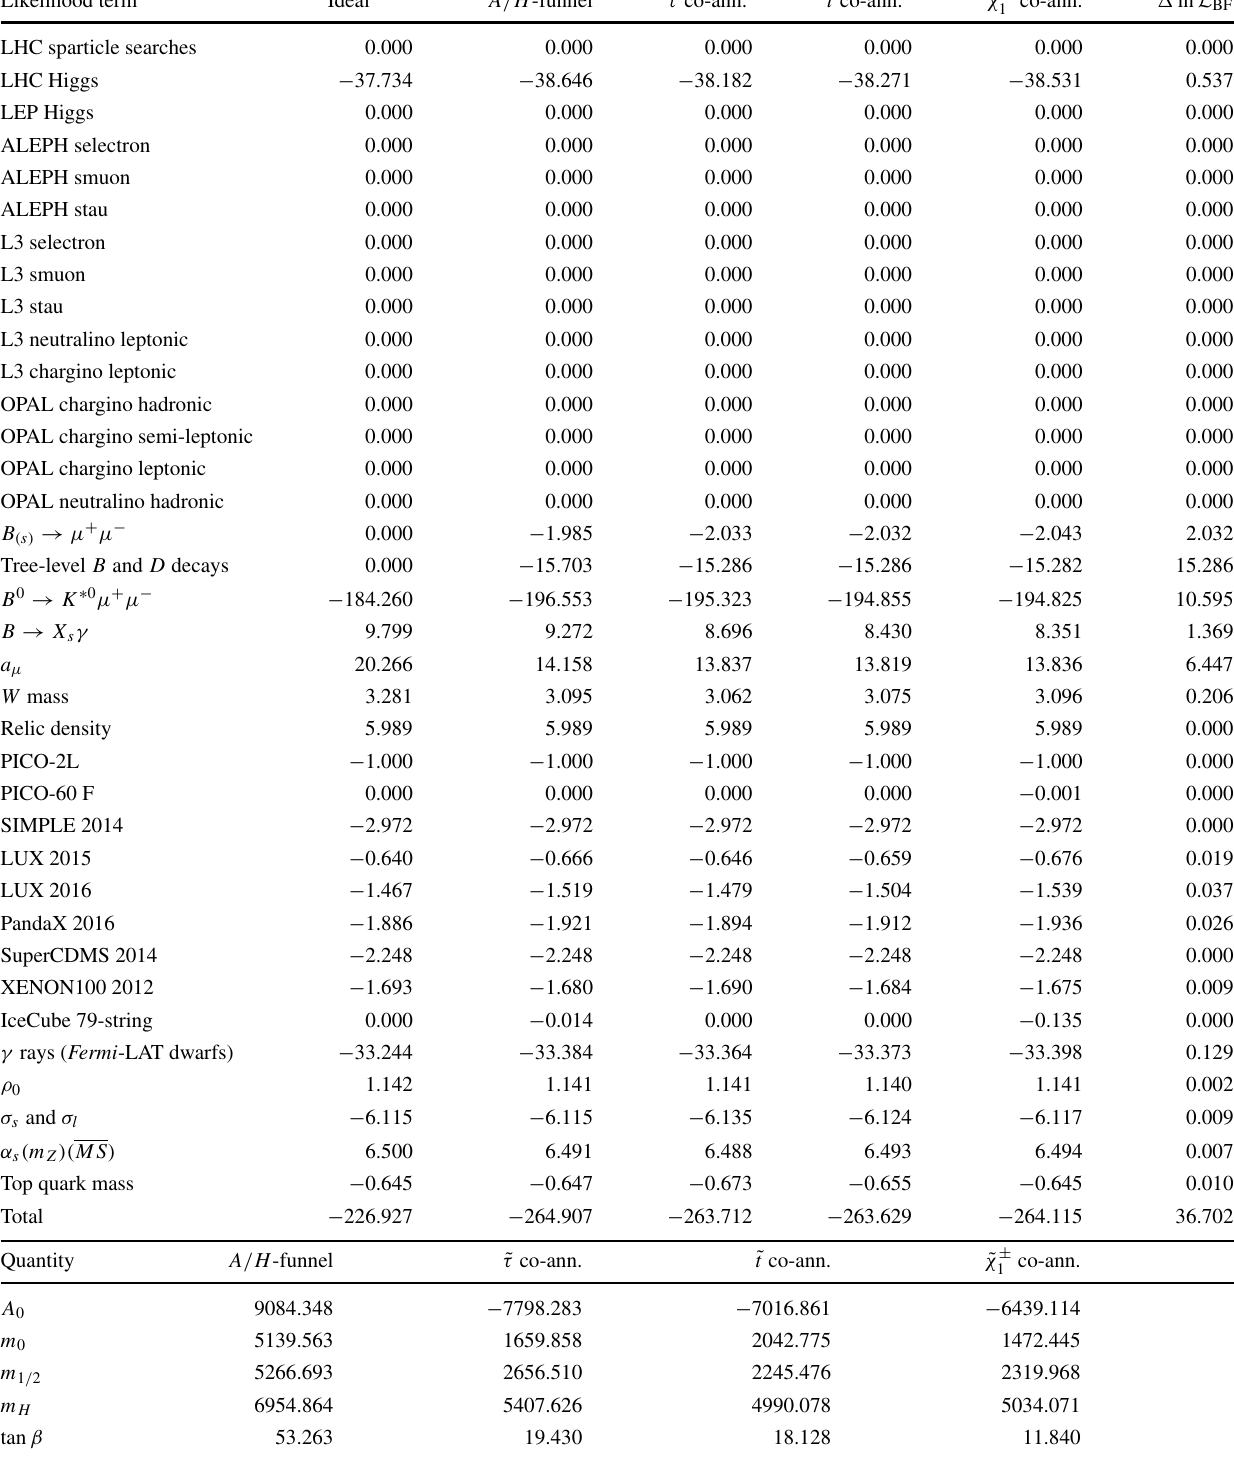
Table 6 Best-fit points in the NUHM1, for each of the regions charac- terised by a specific mechanism for suppressing the relic density of dark matter. Here we show the likelihood contributions, parameter values at each point, and some quantities relevant for the interpretation of mass spectra at the different best fits. We also give likelihood components